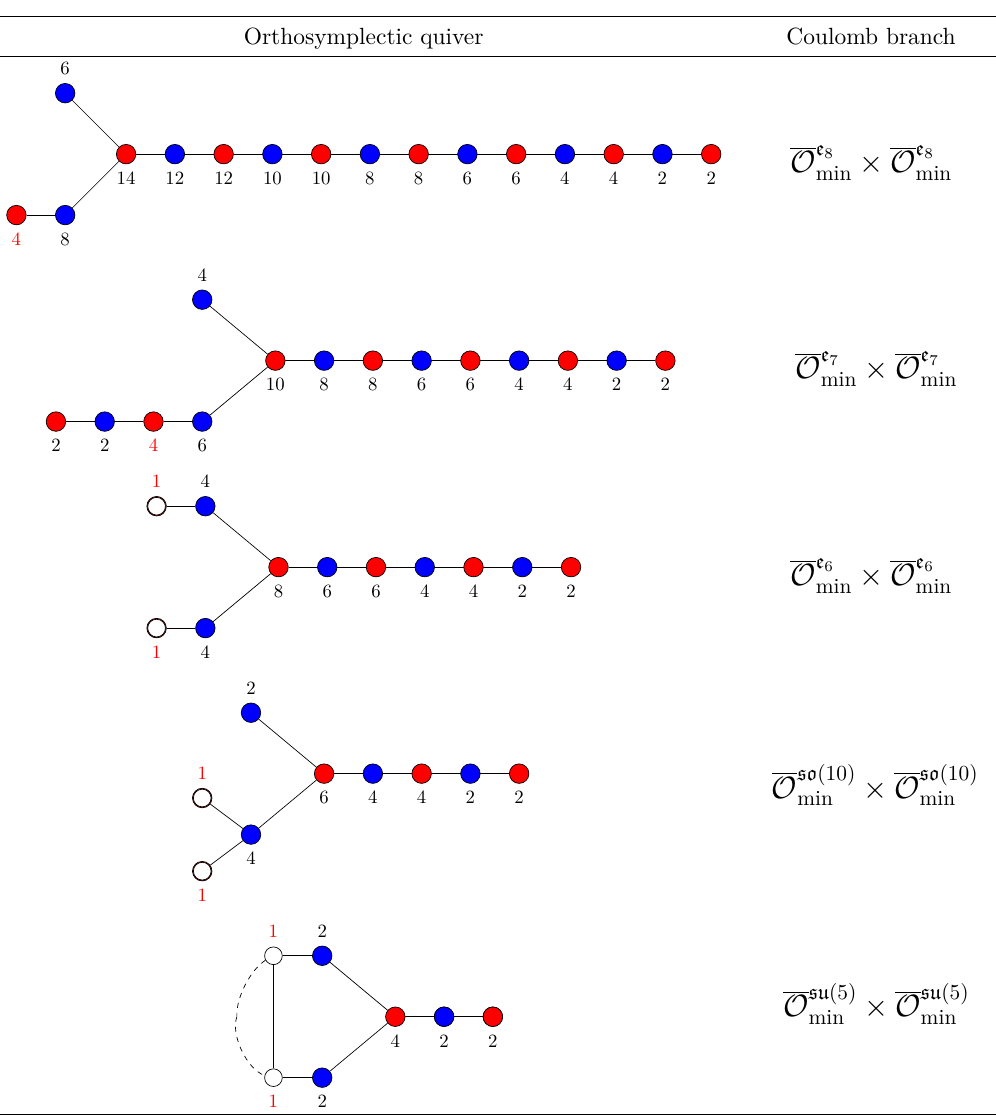
for n = 4 , . . . , 8 . The numbers coloured n